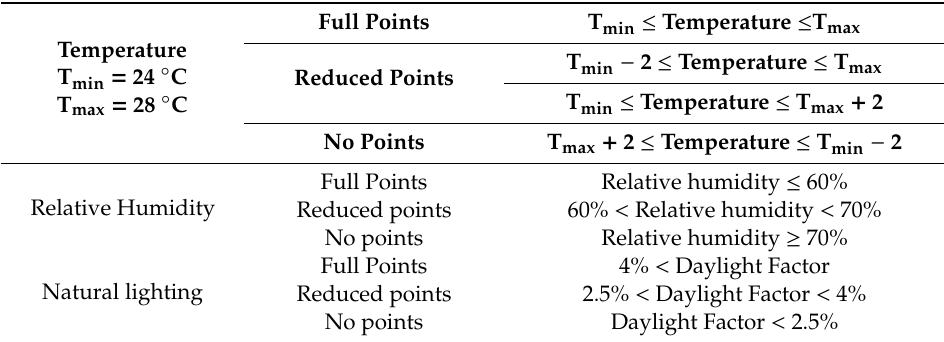
Table 4. Sub-category score range.